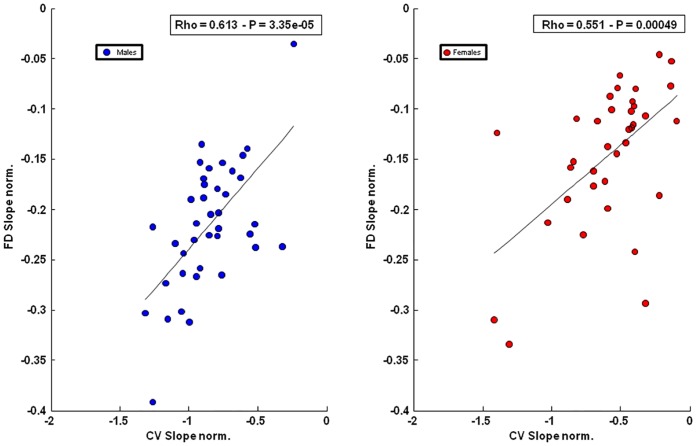
Scatter plots of the normalized slopes of FD versus CV for males (left) and females (right), at 60% of MVC isometric contraction.